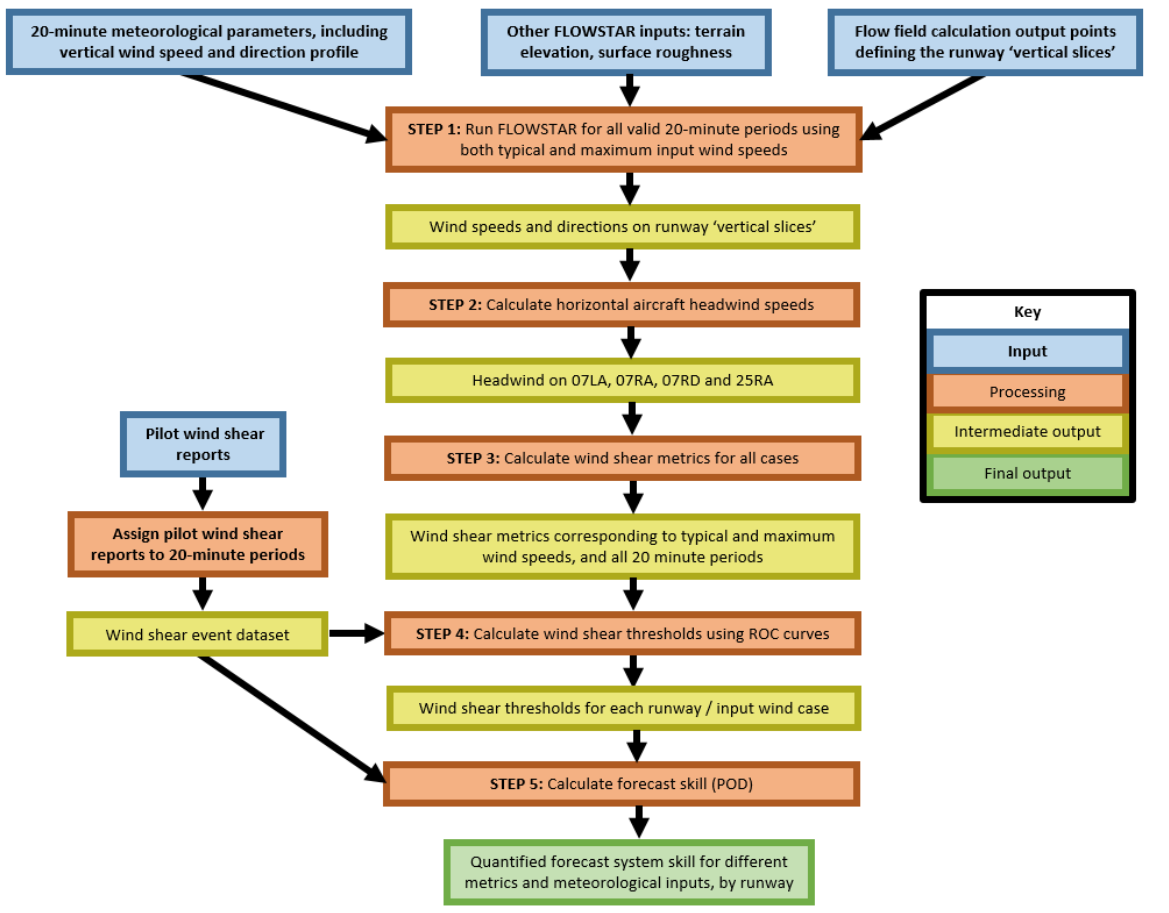
Figure 3. Flow chart showing data: processing and evaluation steps (orange), inputs (blue), intermediate outputs (yellow), and final outputs (green).